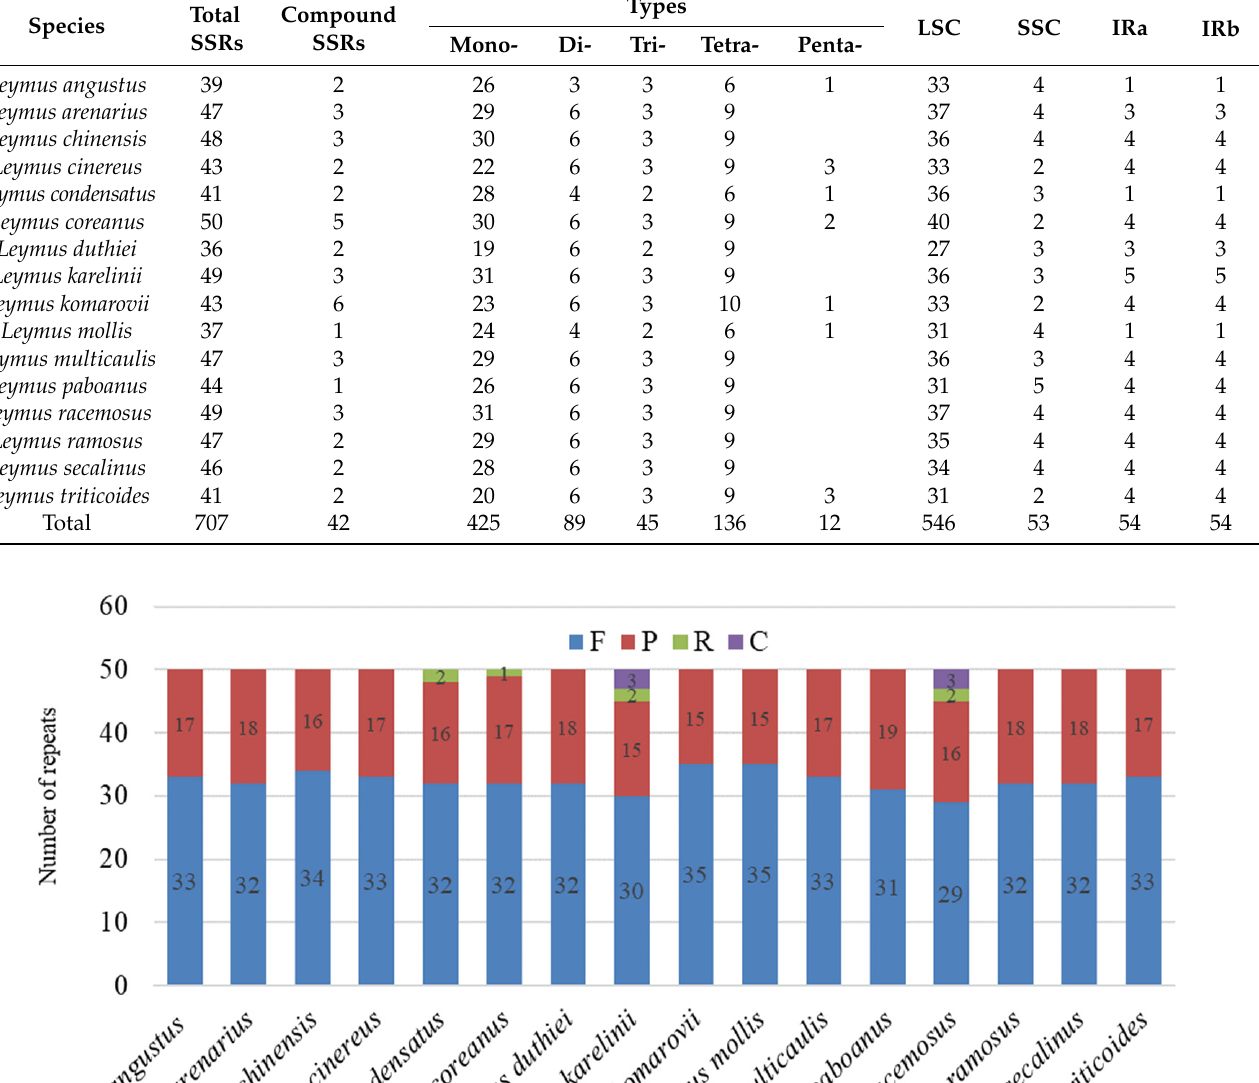
Table 1. Number of SSRs in the chloroplast genomes of 16 Leymus species.